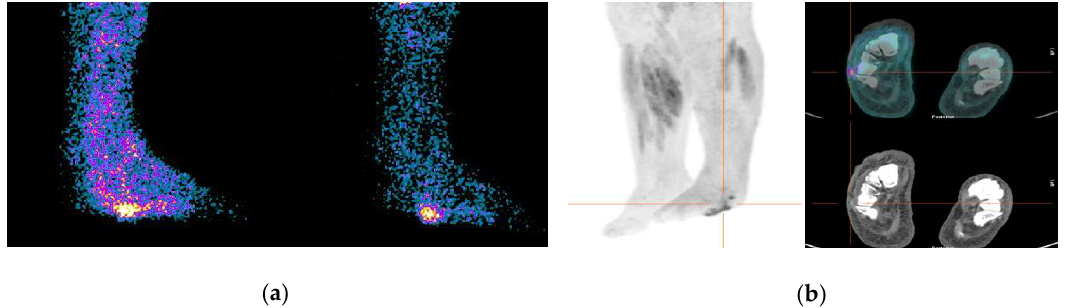
Figure 2. ( a ) Planar images of the WBC scan acquired with correction for 99m Technetium ( 99m Tc) decay at 3 h (on the left) and 20 h (on the right). The focal uptake of labelled leukocytes detectable on the plantar surface of the left foot decreases between the 3 and 20 h images, being consistent with the diagnosis of STI; ( b ) Multi Intensity Projection (MIP) and transaxial views of FDG PET/CT, of the same patient, show the focal uptake in the plantar surface of the left foot in correspondence with a cutaneous/subcutaneous ulcer of the soft tissues. Bone and soft tissue biopsies confirmed the diagnosis of STI and the patient was treated with topic antibiotic therapy. WBC: white blood cells scintigraphy; FDG PET/CT, fluorodeoxyglucose positron emission tomography/computed tomography.